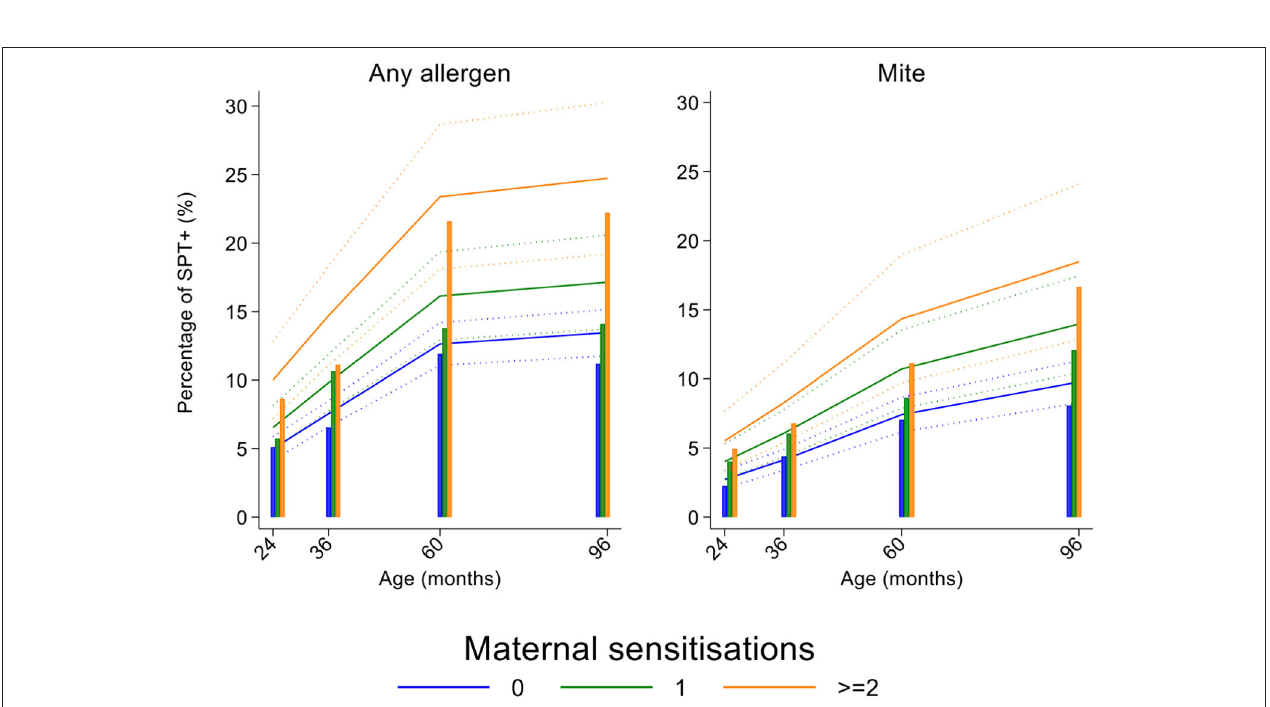
FIGURE 5 | Effects of number of maternal allergen skin prick test positive (SPT + ) reactions on age-dependent proportions of cohort children with SPT + to any allergen and to mite. Shown are predictions from population average longitudinal models (predictions shown by solid lines and 95% confidence intervals by dotted lines) against raw data percentages (bars) stratified by maternal sensitizations. Blue lines/bars − 0 maternal SPT + reactions; green lines/bars − 1 SPT + reaction; orange lines/bars—two or more SPT + reactions.